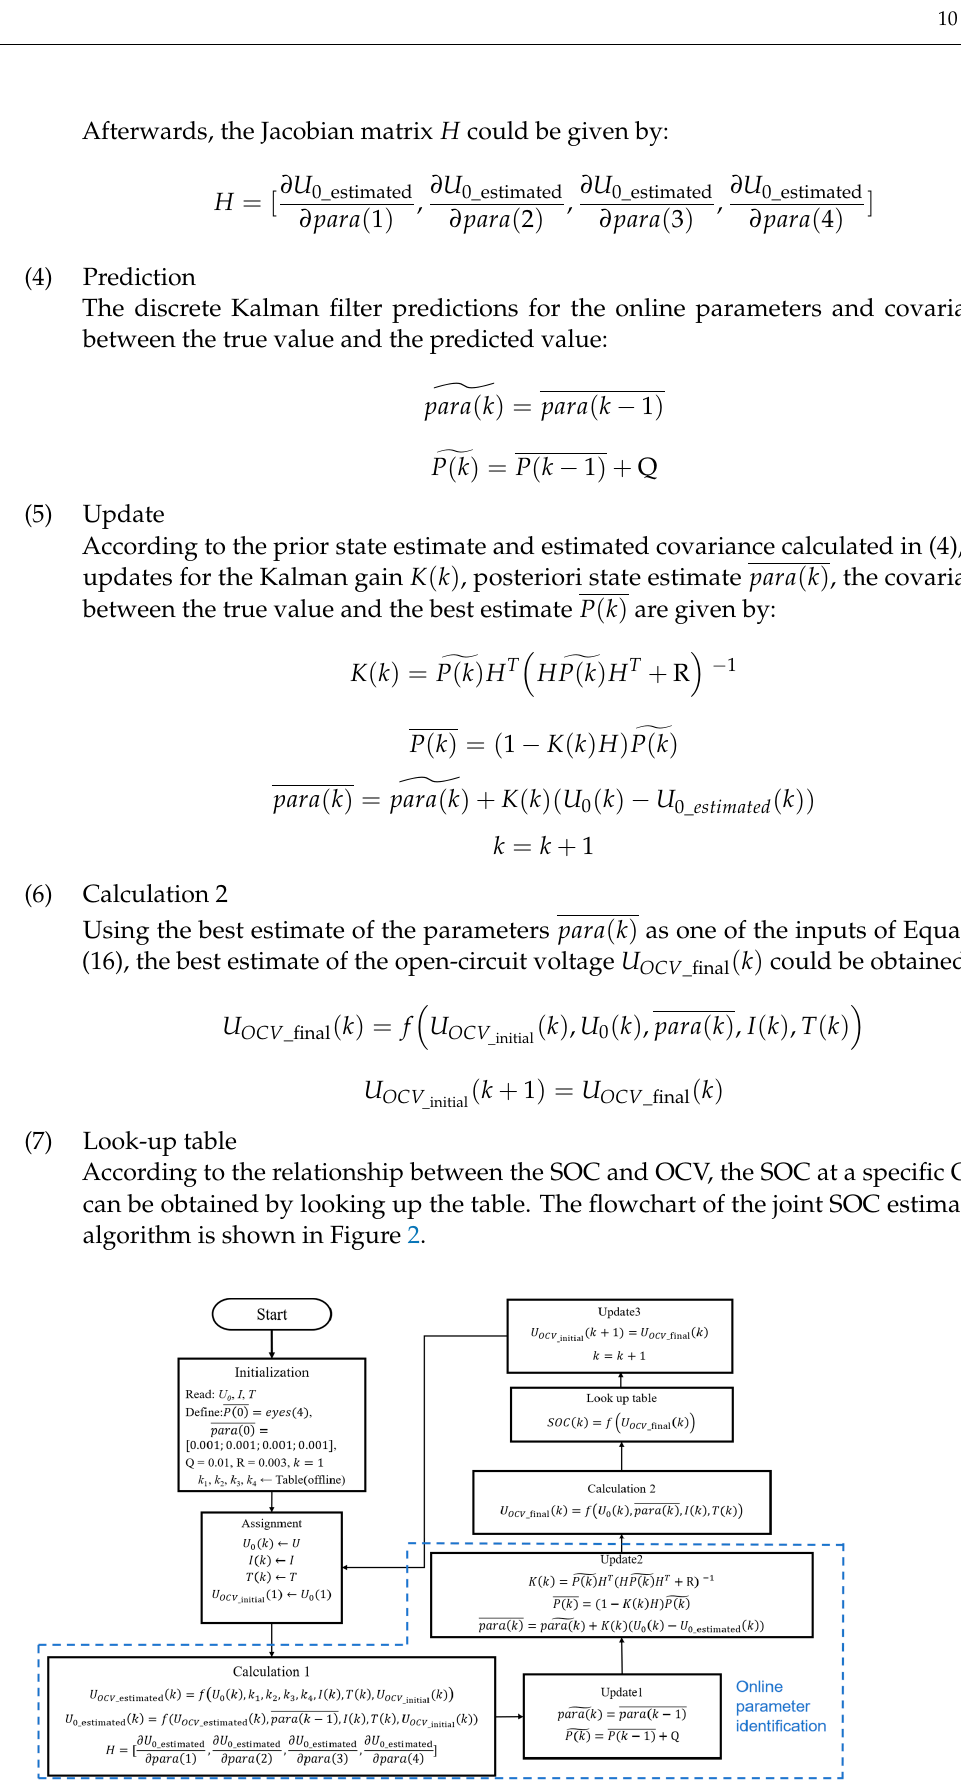
Figure 2. The flowchart of the joint state-of-charge (SOC) estimation algorithm.